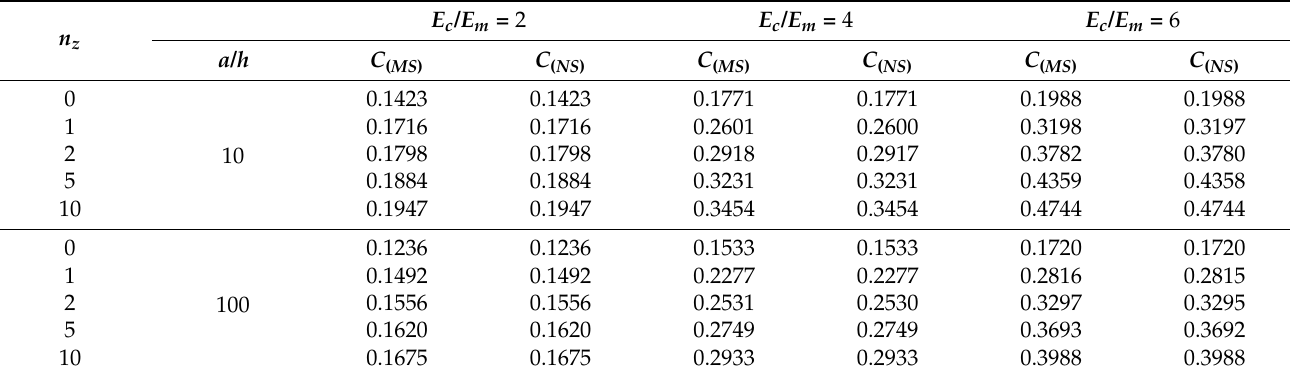
Figure 4. Comparison of displacement distributions ( u 0 , v 0 , ˆ w ) based on neutral surface formulation for movable and immovable simply supported BDFG Al / Al 2 O 3 square plates under a uniform load. Table 3. Non-dimensional deflection w of a BDFG square clamped plate subjected to sinusoidal load based on middle surface formulation C ( MS ) and neutral surface formulation C ( NS ) at n x = 1 for different E c / E m and a / h